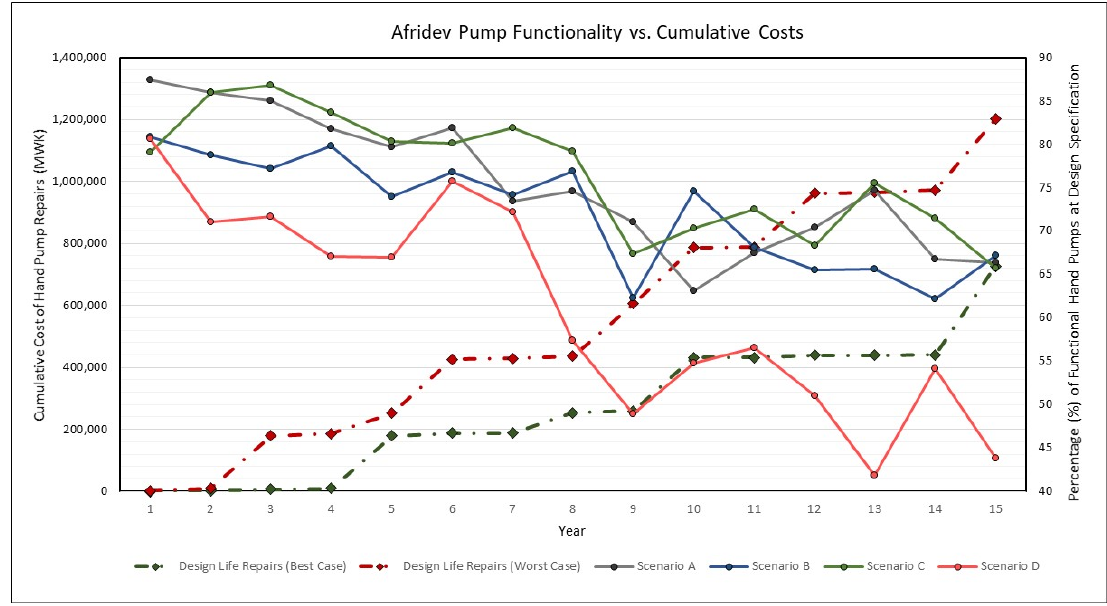
Figure 8. Projected range of cumulative costs for operation and management of Afridev water supplies, compared with the long-term functionality of the water supply over its 15-year design lifecycle (adapted from Truslove, et al., 2020 [28]).